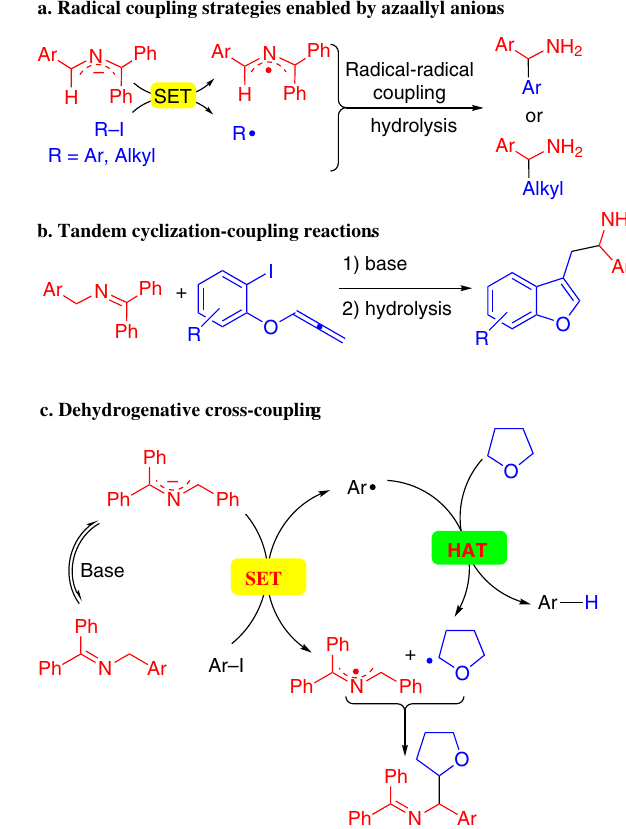
Fig. 3 SET reactions with 2-azaallyl anions. a Transition-metal-free cross- coupling reactions. b Cyclization/radical-radical coupling processes for the synthesis of benzofurans. c Dehydrogenative cross-coupling reactions.